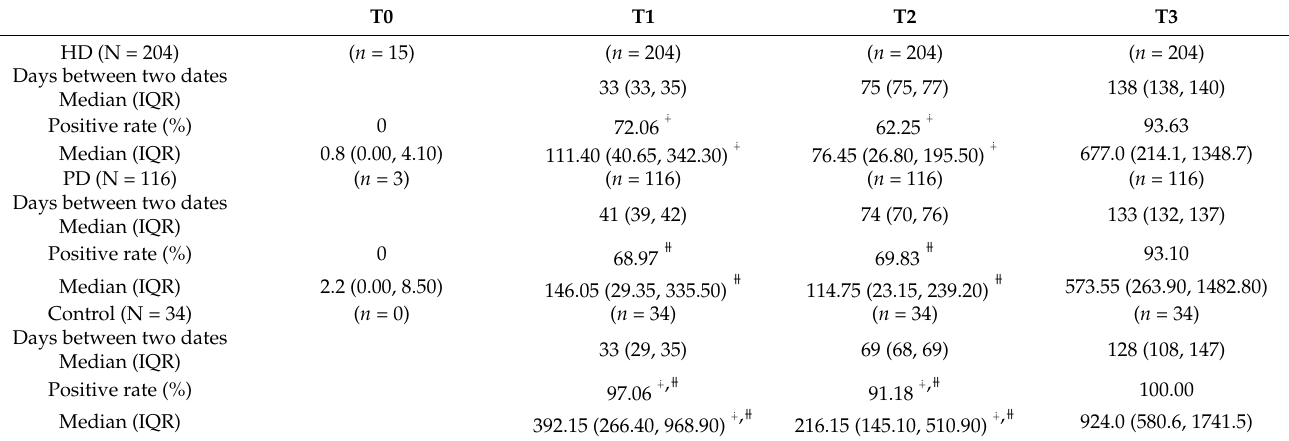
Table 2. SARS-CoV-2 RBD IgG antibody titer values by group and time.